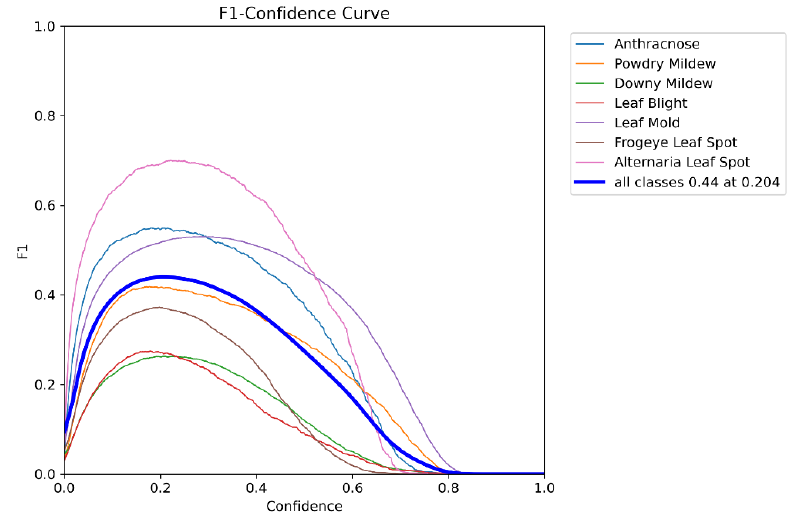
Figure 13. F1 ‐ Confidence of Object Detection Model. Figure 13. F1‑Confidence of Object Detection Model.